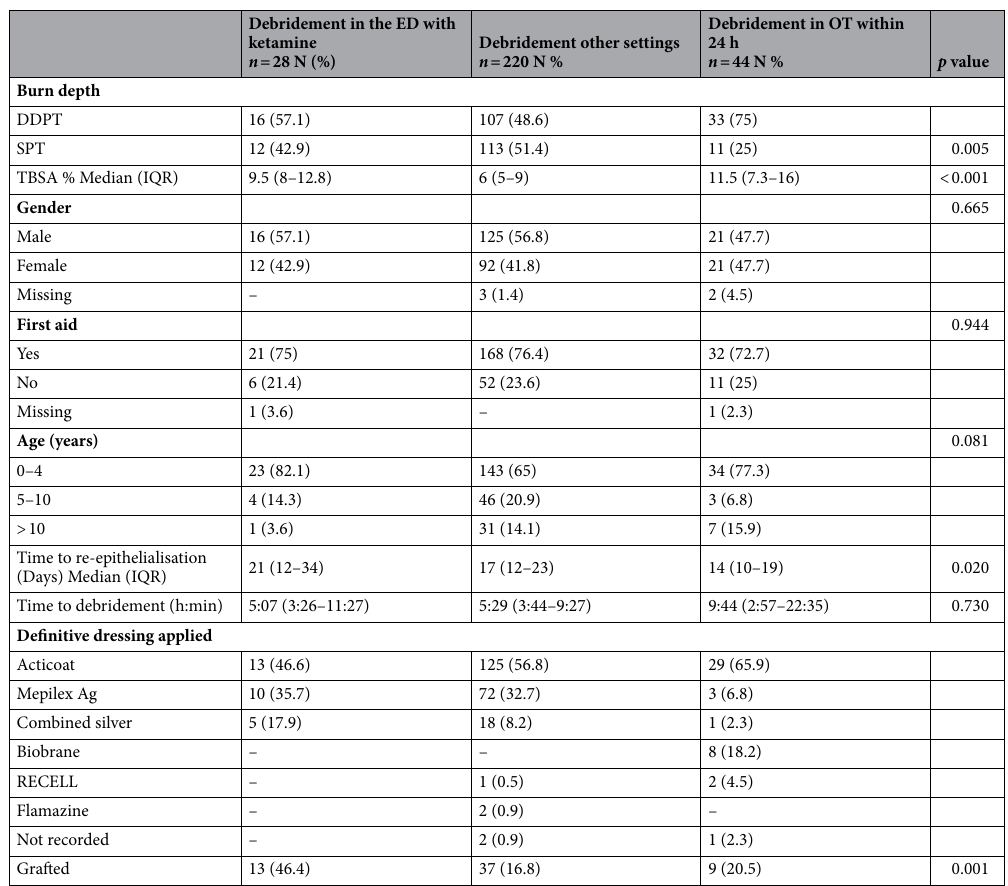
Table 1. Characteristics of patients: debrided in the ED under ketamine PSA, debrided in other settings, and debrided in the OT within 24 h. DDPT deep dermal partial thickness, SPT superficial partial thickness, TBSA Silver = Acticoat + Mepilex Ag + Hypafix applied to burns.